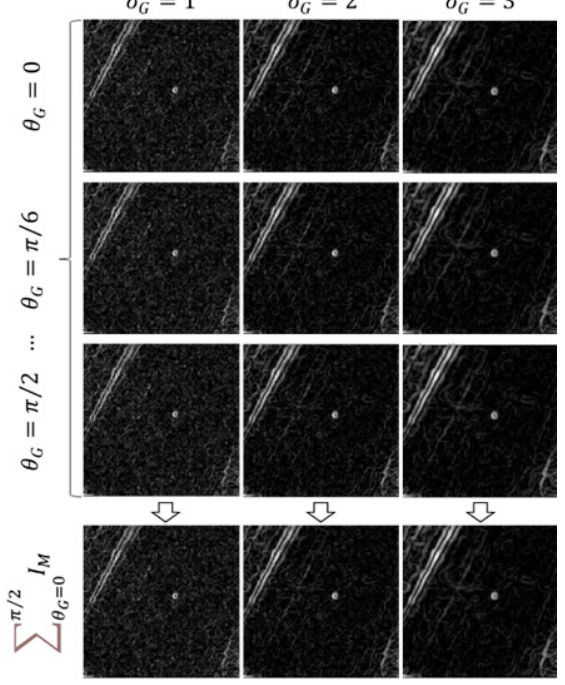
Figure 3. G radient significance images in different scales and orientations. Figure 3. Gradient significance images in different scales and